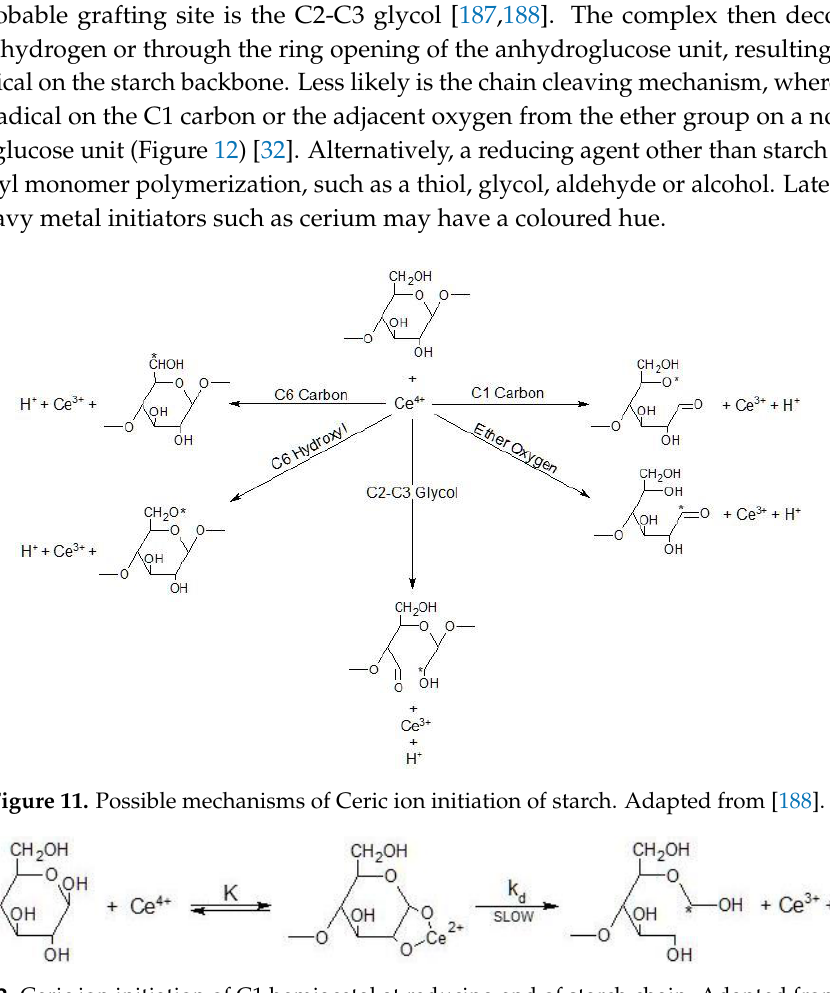
Figure 12. Ceric ion initiation of C1 hemiacetal at reducing end of starch chain. Adapted from [187].